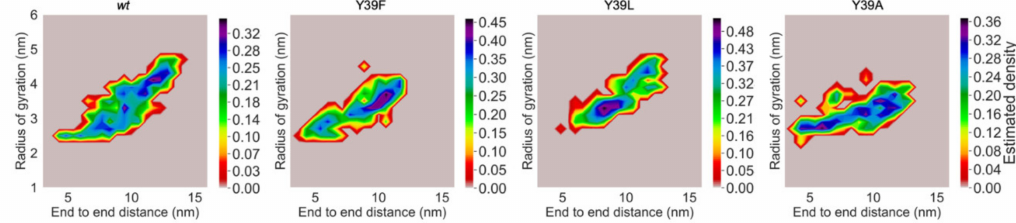
Figure 5. Conformational preferences observed for wt α S and its Y39A, Y39F, and Y39L mutants. Density maps of the radius of gyration (RG) and end-to-end (EE) distance reaction coordinates for the simulated structural ensembles.